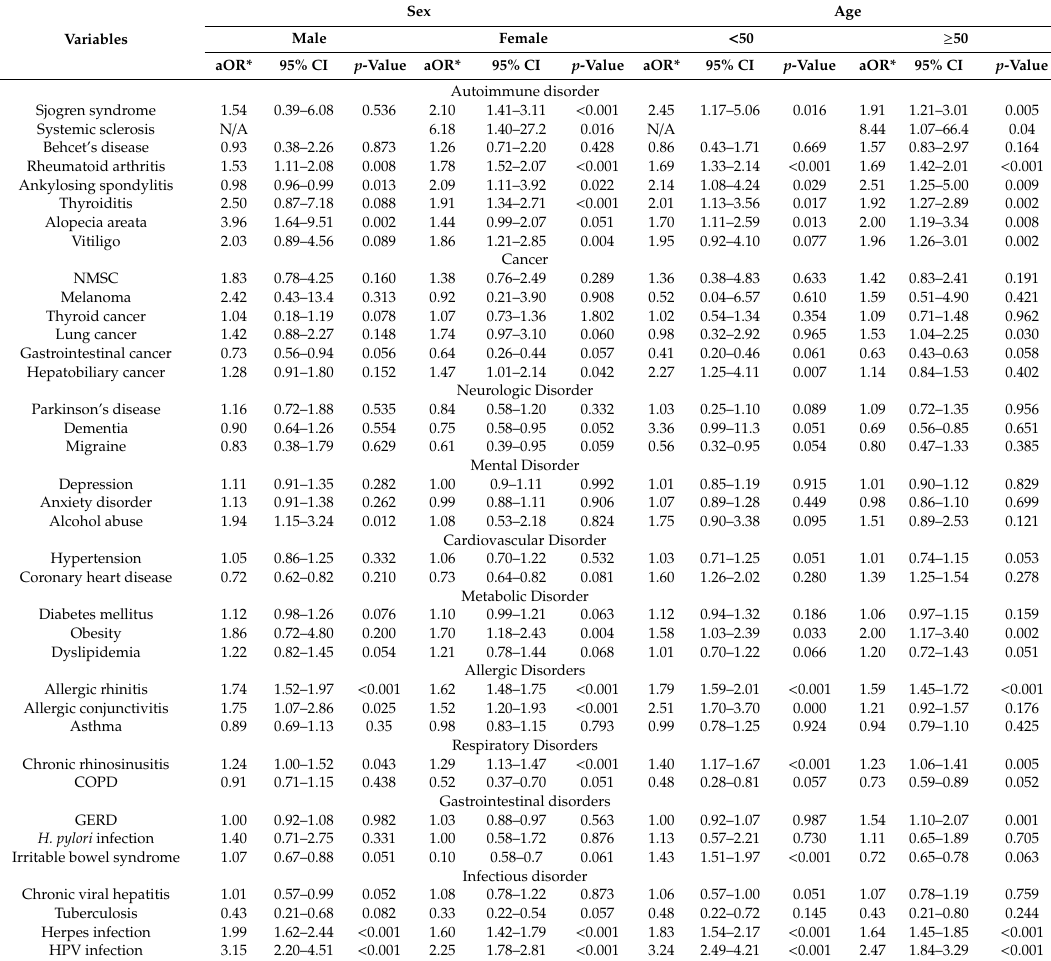
Table 3. Subgroup analyses of the association between rosacea and systemic diseases by sex and age.